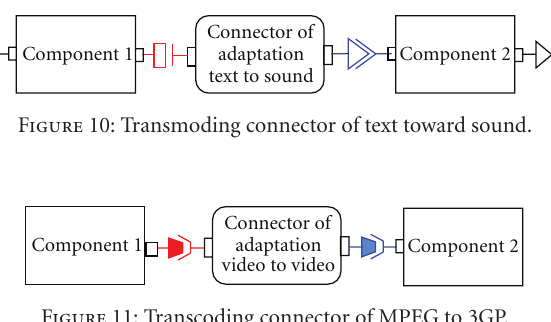
Figure 11: Transcoding connector of MPEG to